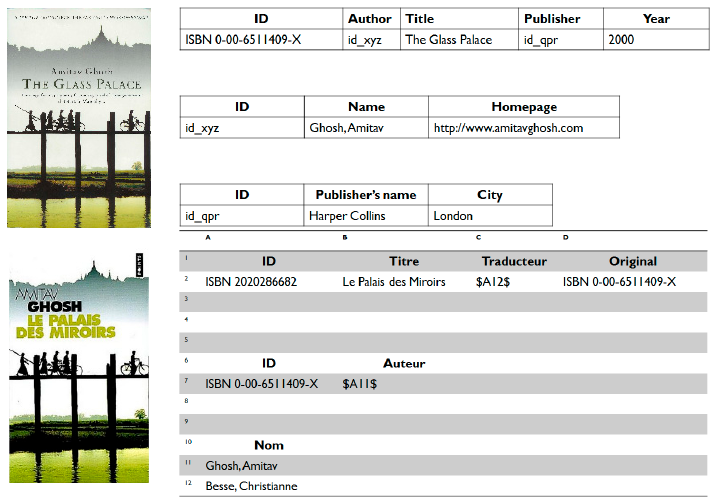
Figure 2. Different Web media for the same book ( left ); and their corresponding relational schemas ( right ) [41].